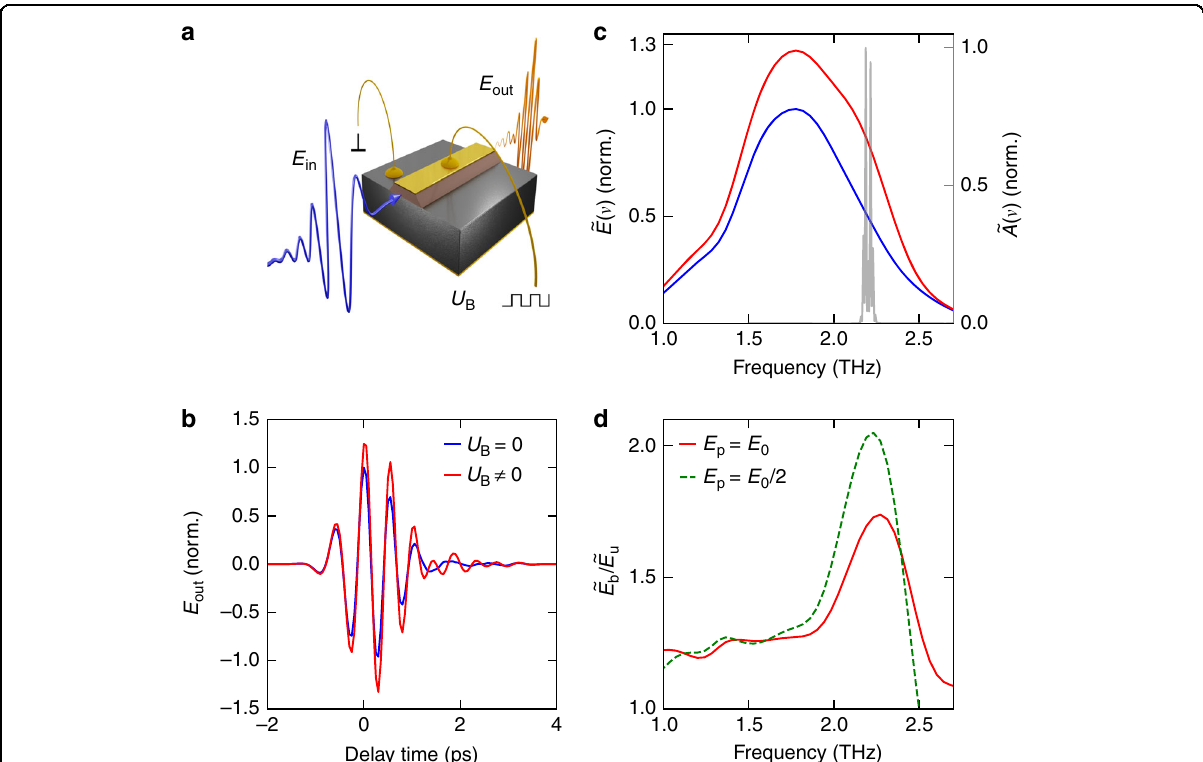
Fig. 1 High- fi eld spectroscopy of a THz QCL. a Experimental arrangement; gray: GaAs substrate, red: active medium, gold: waveguide and electrical contacts. The THz waveform E in (blue) is focused onto the QCL facet and the transmitted waveform ( E out , orange) is detected electro- optically. The rectangular modulation of the bias voltage allows the current-induced change of the nonlinear response to be extracted. b Measured THz waveform as a function of delay time t , after the transmission through the QCL with (red) and without (blue) bias current. c Amplitude spectrum ~ E ν ð Þ of the waveforms in b and lasing spectrum ~ A ν ð Þ of the QCL (gray). d Modulation of the transmission through the QCL as a function of frequency, de fi ned as the ratio of the transmission spectra of the biased and the unbiased QCL (see c ) for two peak electric fi elds E p = E 0 = 1.4 kV cm − 1 (red) and E p = E 0 /2 (green, broken